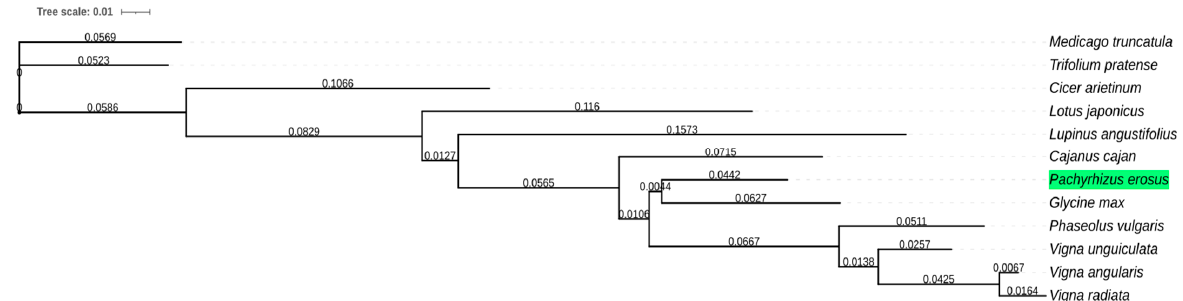
Figure 1. A phylogeny tree based on orthologous protein groups identified in OrthoFinder. Yam bean ( Pachyrhizus erosus ) is highlighted in green. Out of the legume species selected, yam bean is predicted to be most closely related to Glycine max .